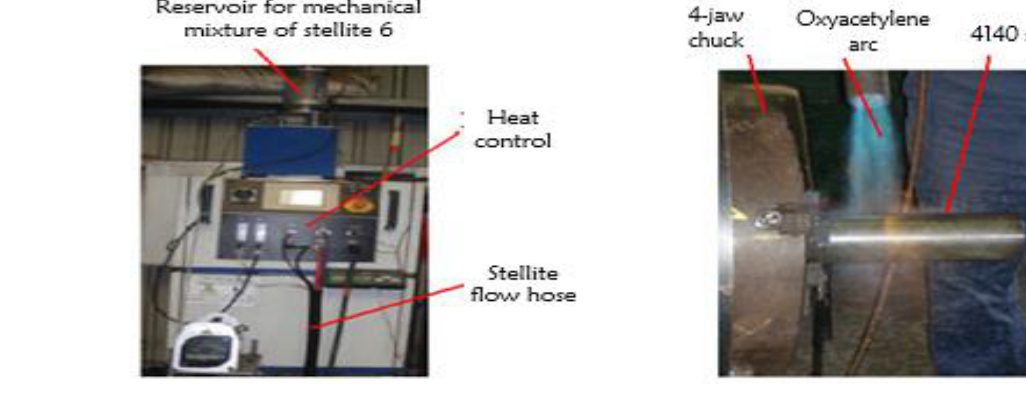
Figure 3: Plasma Arc Cladding Unit Figure 4: Steel Bar Heating